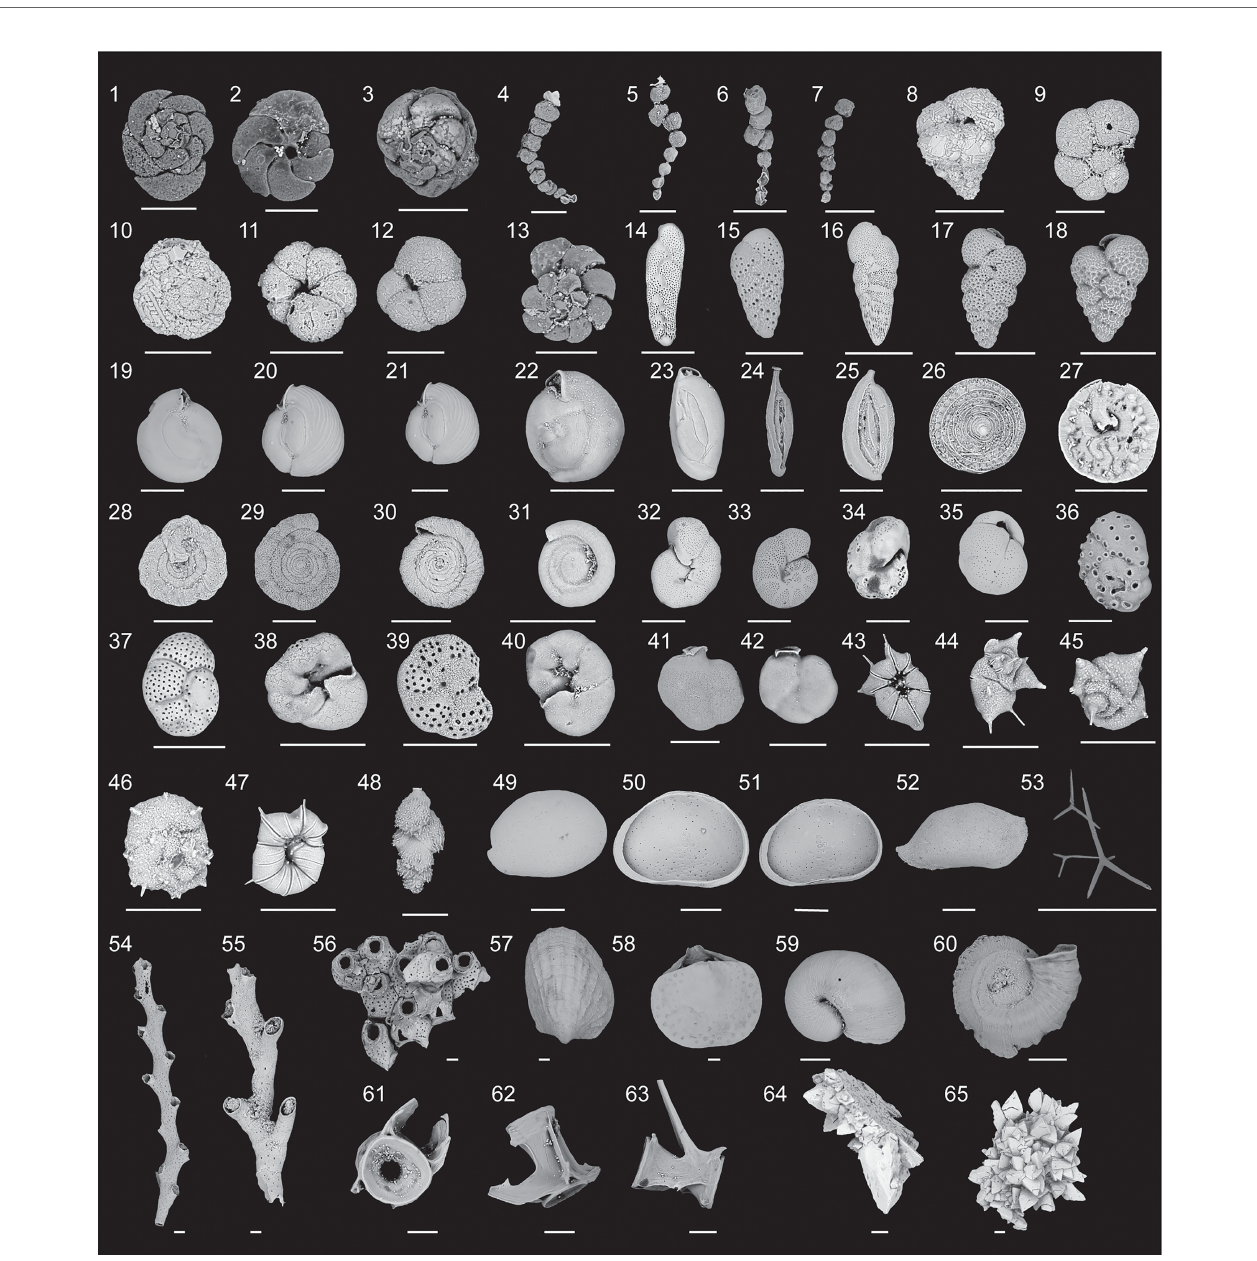
FIGURE 4 | Scanning electron micrographs of representative biological and sedimentary remains (1-48, benthic foraminifera; 49- 65, other). 1-3, Dorsal and ventral views of Tiphotrocha comprimata (Cushman and Brönnimann, 1948). 4-7, Polysaccammina ipohalina (Scott, 1976). 8, Eggerella scabra (Williamson, 1858). 9, Labrospira evoluta (Natland, 1938). 10-12, Dorsal and ventral views of Trochammina quadriloba (Höglund, 1947). 13, Entzia macrescens (Brady and Robertson, 1870).14, Bolivina pseudopunctata (Höglund, 1947). 15, Bolivina paula (Cushman and Ponton, 1932). 16, Bolivina striatula (Cushman, 1922). 17-18, Bolivina variablis (Williamson, 1858). 19-22, Miliolinella circularis (Bornemann, 1855). 23, Quinqueloculina bosciana (D ’ Orbigny, 1839 ). 24, Spirophthalmidium emaciatum (Haynes, 1973). 25 Sigmoilina tenuis (Czjzek, 1848). 26-27, Patellina corrugata Williamson (1858). 28, Mychostomina revertens (Rhumbler, 1906). 29- 30, Spirillina vivipara (Ehrenberg, 1843). 31, Cyclogyra involvens (Reuss, 1850). 32-33, Melonis barleeanum (Williamson, 1858). 34, Nonion pauperatum (Balkwill and Wright, 1885). 35, Globocassidulina subglobosa (Brady, 1881). 36, Dorsal view of Svratkina australiensis (Chapman et al., 1934). 37- 40, Dorsal and ventral views of Rosalina spp. 41-43, Siphonina temblorensis (Garrison, 1959). 43-45, Dorsal and ventral views of Rotaliella arctica (Scott and Vilks, 1991). 46-47, Dorsal and ventral views of Heronallenita spp. 48, Trifarina occidentalis (Cushman, 1922). 49 dorsal view of ostracode Cypridopsis vidua (Müller). 50-51, ventral view of ostracode Cypridopsis vidua (Müller), 52, dorsal view of Paranesidea sterreri Maddocks (Maddocks and Iliffe, 1986). 53. Sponge spicules. 54- 55, Branching bryozoans. 56, Cheilostome bryozoan. 57, Bivalve. 58, Brachiopod. 59, Mollusk. 60, Encrusting tube-worm. 61- 63, Teleost (Fish) vertebrae. 64-65, Calcite rafts. All scale bars represent 100 m